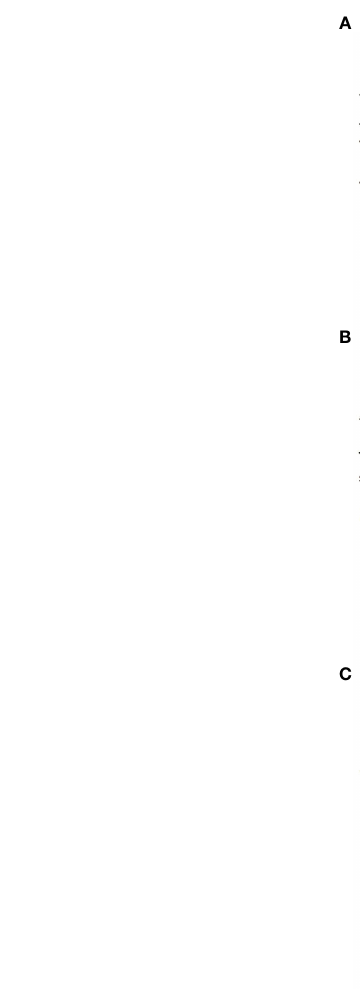
FIGURE 4 Analysis on the differences of three indicators between diabetic patients and non-diabetic patients of different races. (A) Leg length; (B) BMI; (C) TCHOL. *** P<0.001 vs diabetes; **